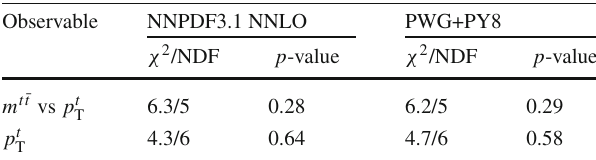
Table 28 Comparison of the measured parton-level absolute differen- tial cross-sections in the boosted topology with the NNLO predictions and the nominal Powheg + Pythia8 predictions. For each prediction a χ 2 and a p -value are calculated using the covariance matrix of the measured spectrum. The NDF is equal to the number of bins in the